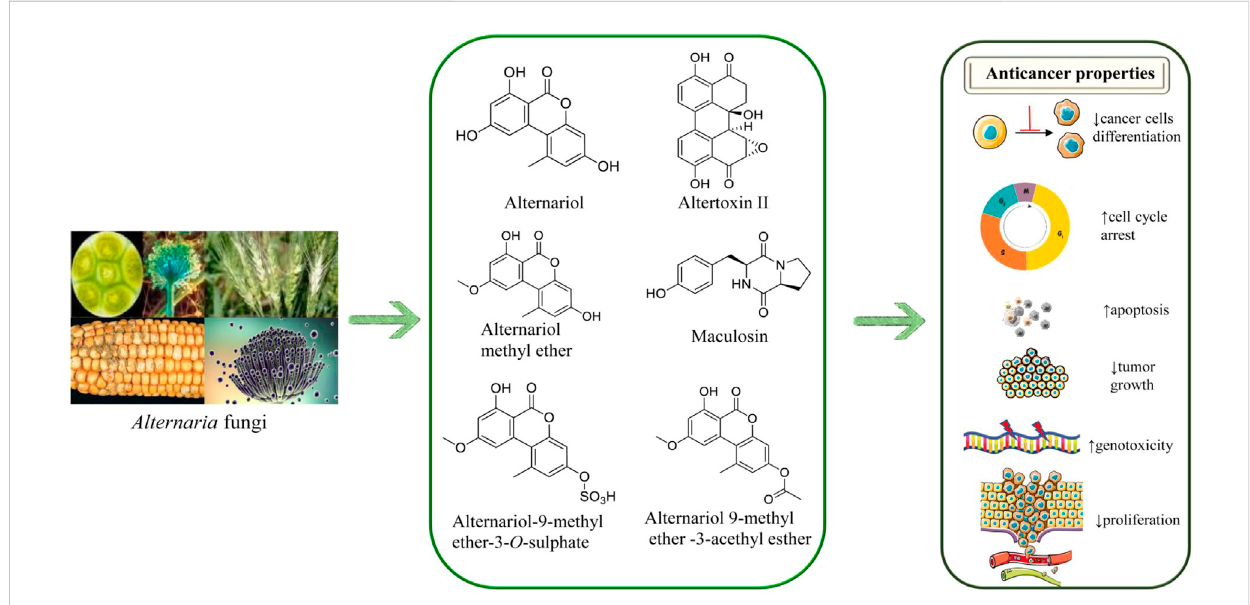
FIGURE 1 The chemical structures of Alternariol and its derivatives and their anticancer potential mechanisms. Symbols: ↑ (increased), ↓ (decreased).